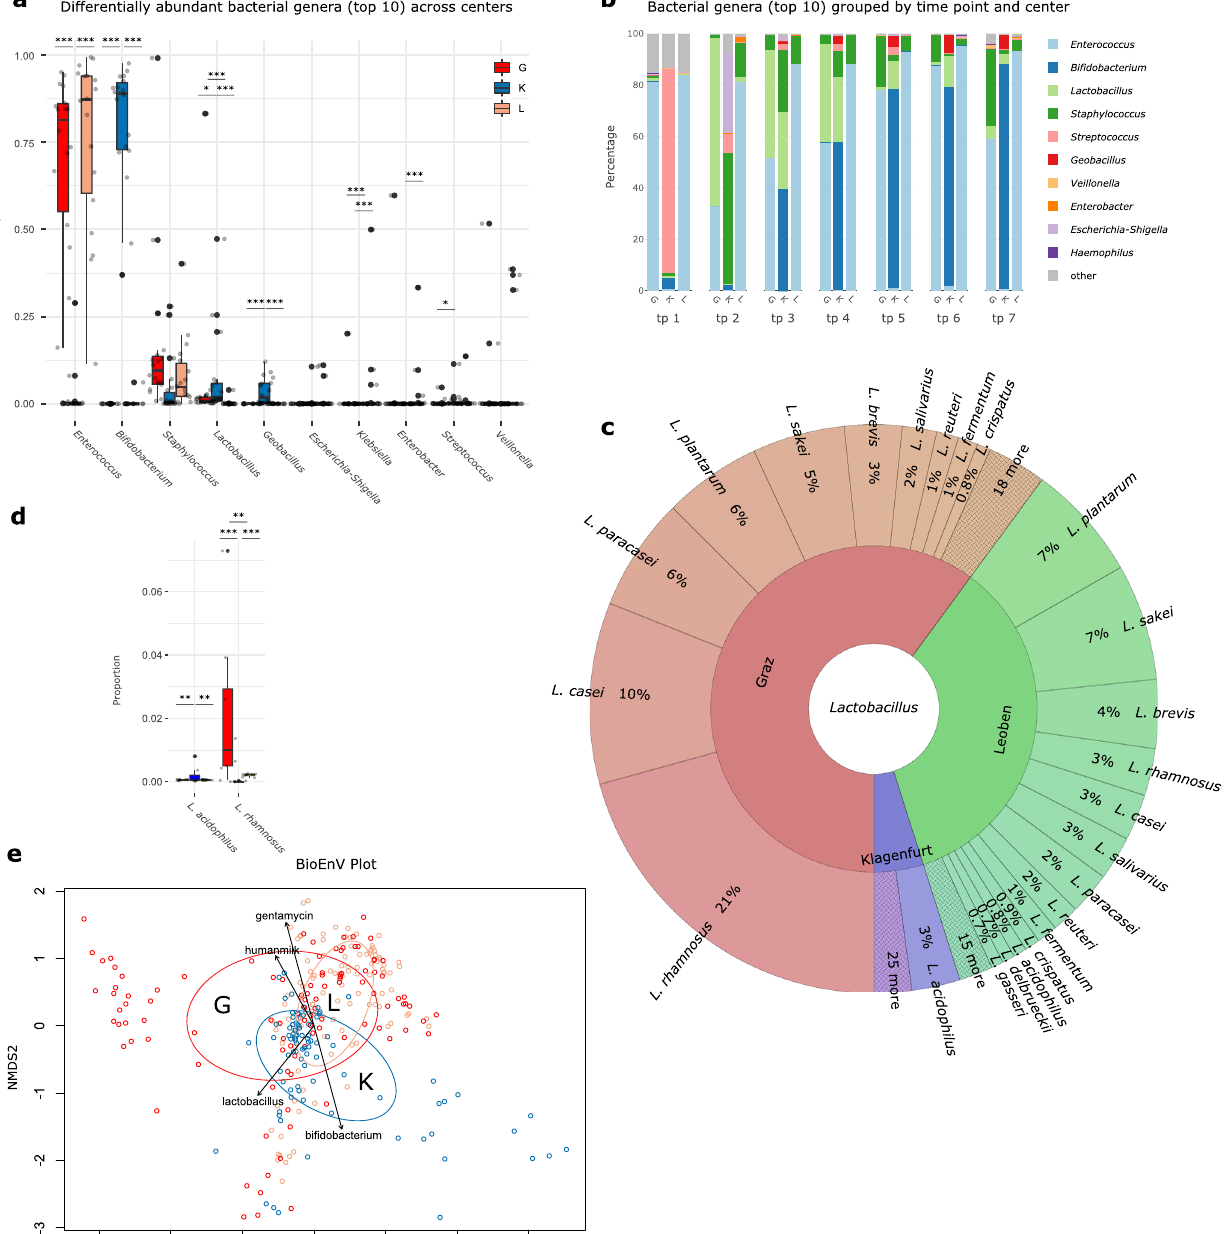
Fig. 2 | Distribution of bacterial taxa between the centers and in fl uence of probioticspecies.a Boxplotofrelativeabundancesofthetoptenbacterialgenera per center (amplicon data, tp7, n =23 biologically independent samples, DSeq2) Enterococcus : K:G q <0.001, K:L q <0.001, G:L q =1; Bi fi dobacterium : K:G q <0.001, K:L q <0.001, G:L q =1; Staphylococcus : K:G q =0.642, K:L q =1, G:L q =0.274; Lac- tobacillus :K:G q =0.034,K:L q <0.001,G:L q <0.001; Geobacillus :K:G q <0.001,K:L q <0.001,G:L q =1; Escherichia-Shigella :K:G q =1,K:L q =0.979,G:L q =1; Klebsiella : K:G q =1, K:L q <0.001,G:L q <0.001; Enterobacter : K:G q =0.916,K:L q <0.001, G:L q =1; Streptococcus : K:G q =0.018, K:L q =0.443, G:L q =0.765; Veillonella : K:G q =0.050, K:L q =0.111, G:L q =0.768; b Stacked bar plot of relative abundances of top ten bacterial genera in the amplicon data set per center each at time points tp1 – 7. c Krona chart of the distribution of species of the Lactobacillus genus between the centers (MGS data, tp7). d Log percentages of relative abundance of probiotically administered Lactobacillus genera (MGS data, tp7, n =23 biologically